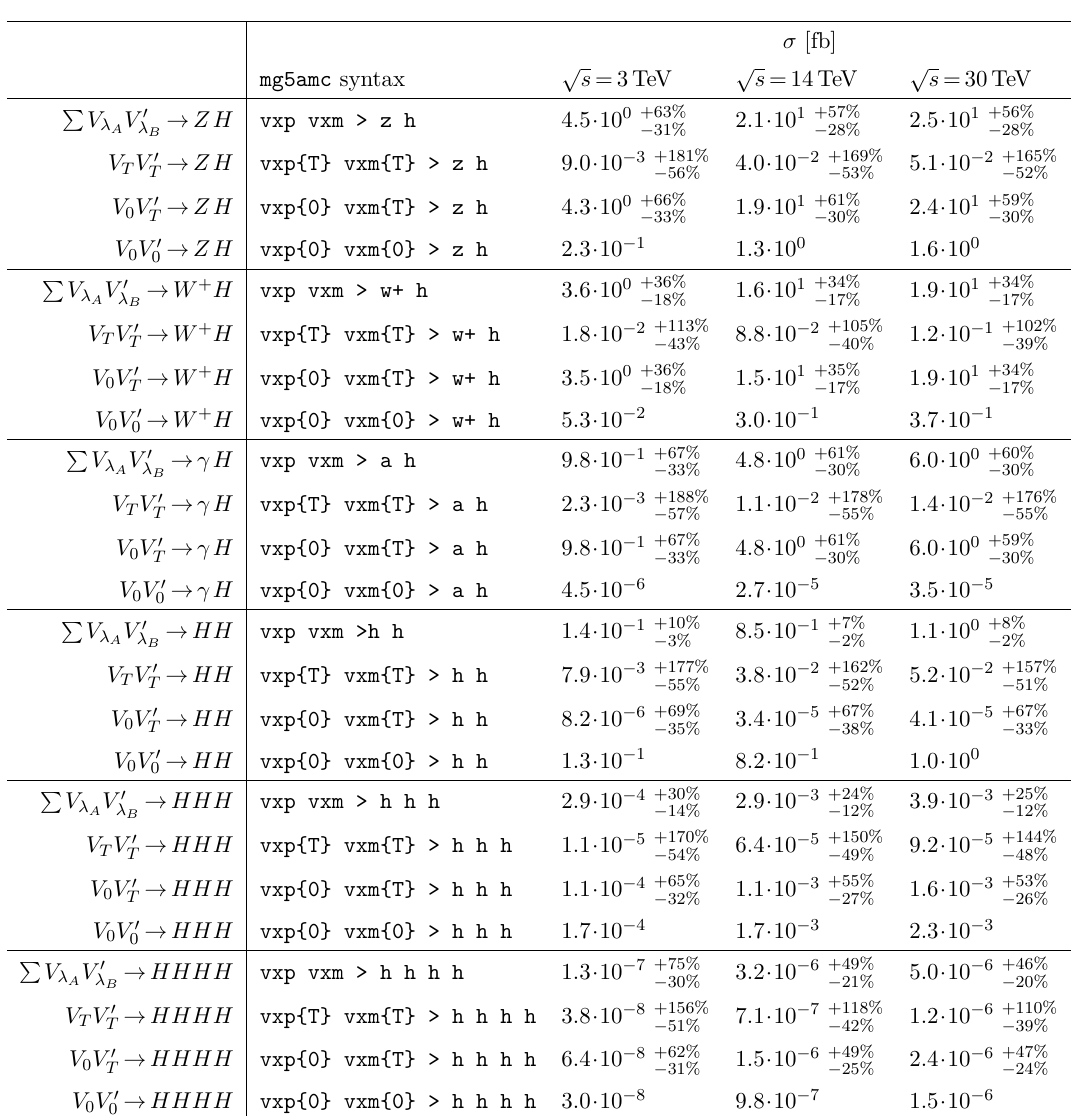
scattering, where V ± 0 } , under the λ A V λ ∈ { γ λ ,Z λ ,W λ B λ √ s = 3 , 14 , and 30 TeV. All helicity